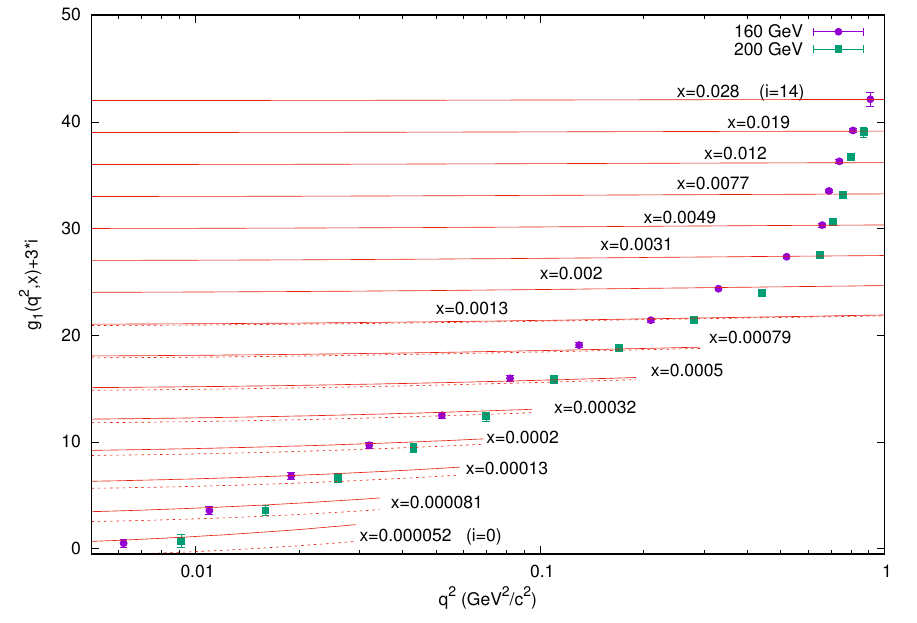
Figure 7. Our best (cid:12)t of the structure function g 1 carried out with the newest data presented in [23]. Solid curves correspond to the best (cid:12)t for the conformal model, with C = 0 : 0112 (cid:6) 0 : 0020 and a (cid:31) 2 = 1 : 140, while dotted lines correspond to the best (cid:12)t for the hard-wall model with d : o : f : C = 0 : 0120 (cid:6) 0 : 0020 and a (cid:31) 2 = 1 : 074. For values above x = 0 : 0013 we only show the conformal d : o : f : model because at the scale used in the plot there are no visible di(cid:11)erences. In this case we do not show the error on C because it is negligible in the displayed scale. Note that for each row corresponding to di(cid:11)erent x value, we are adding the constant 3 i